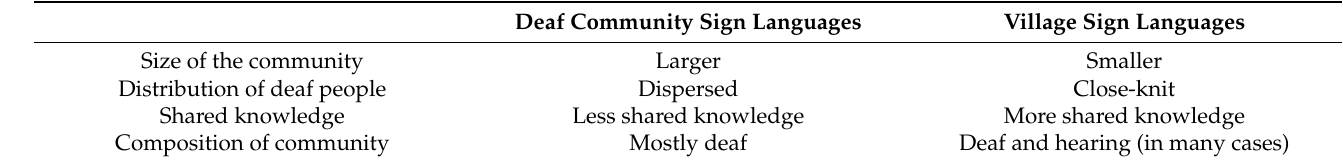
Table 1. Social situation of deaf community and village sign languages (Meir et al. 2010). Deaf Community Sign